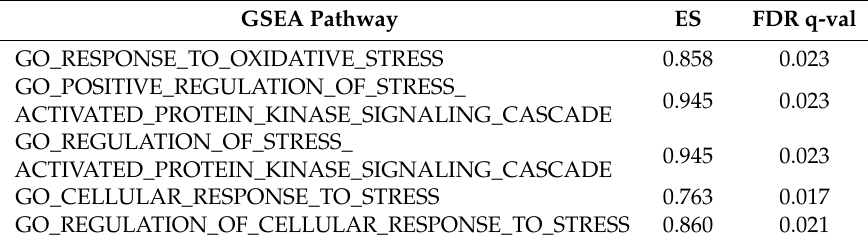
Table 6. Upregulation of oxidative stress related pathways in PCB180 treated